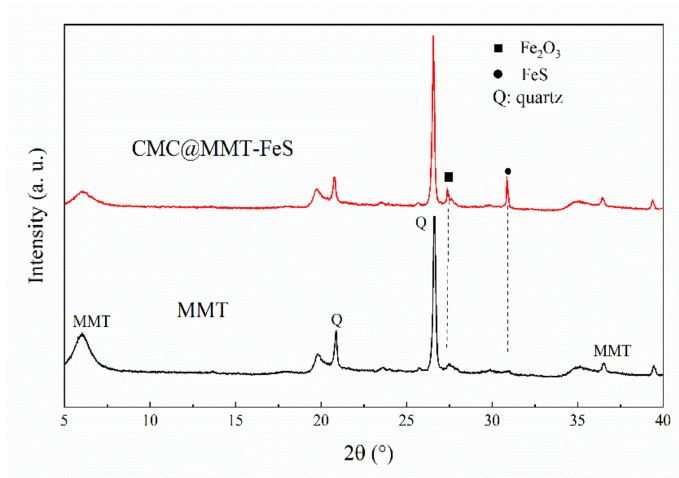
Figure 1. X-ray di ff raction (XRD) pattern analysis of montmorillonite (MMT) and carboxymethyl cellulose-stabilized nanoscale iron sulfide (CMC@MMT-FeS).